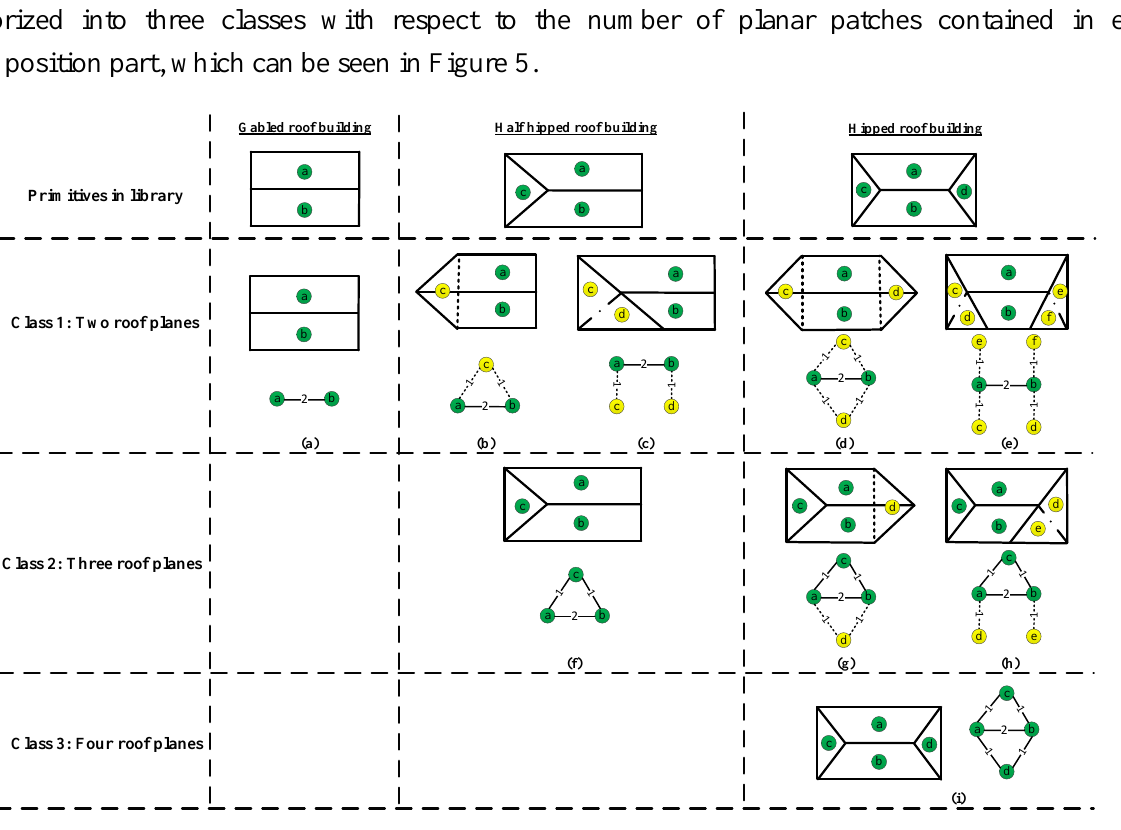
Figure 5. Three classes of primitives defined according to the number of planar patches contained in the decomposition part and the corresponding sub-graphs. ( a ) Gabled roof primitive; ( b ) half hipped roof primitive with convex shape; ( c ) half hipped roof primitive with concave shape; ( d ) hipped roof primitive with convex shape; ( e ) hipped roof primitive with concave shape; ( f ) half hipped roof primitive; ( g ) hipped roof primitive with convex shape; ( h ) hipped roof primitive with concave shape; and ( i ) hipped roof primitive. Note that the yellow vertices (connected with the dotted lines in the sub-graphs) indicate that they are adjacent to the anti-symmetry planar patches but not contained in the corresponding decomposition